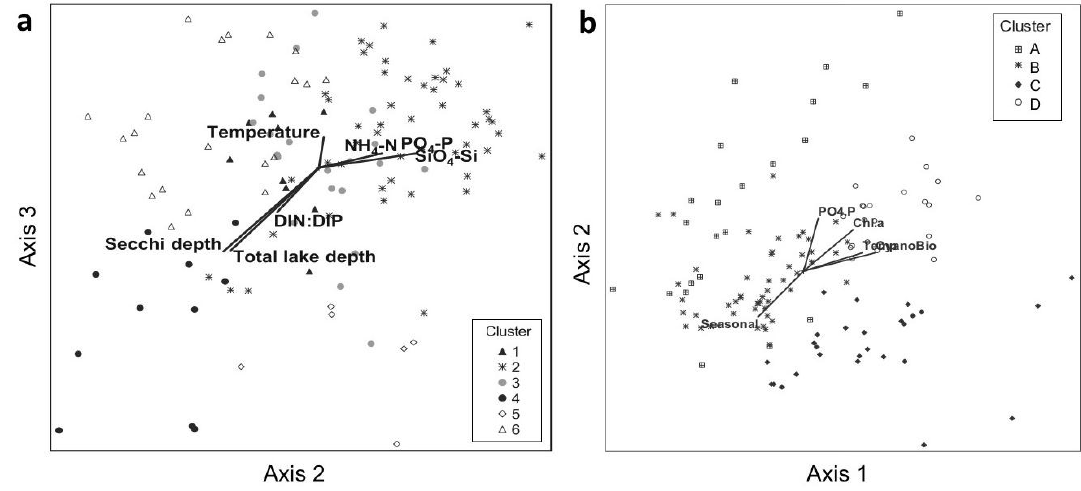
Figure 8. Results of NMDS ordinations examining relationships between environmental variables and ( a ) phytoplankton and ( b ) mesozooplankton assemblage clusters observed in Vancouver Lake from 2007–2010. Each point represents a specific sampling date and each symbol represents a cluster group. The distance between points represents the amount of similarity or dissimilarity in phytoplankton assemblage composition. Vectors are environmental variables associated with each cluster. Data and figures from [61,62], and used with permission.